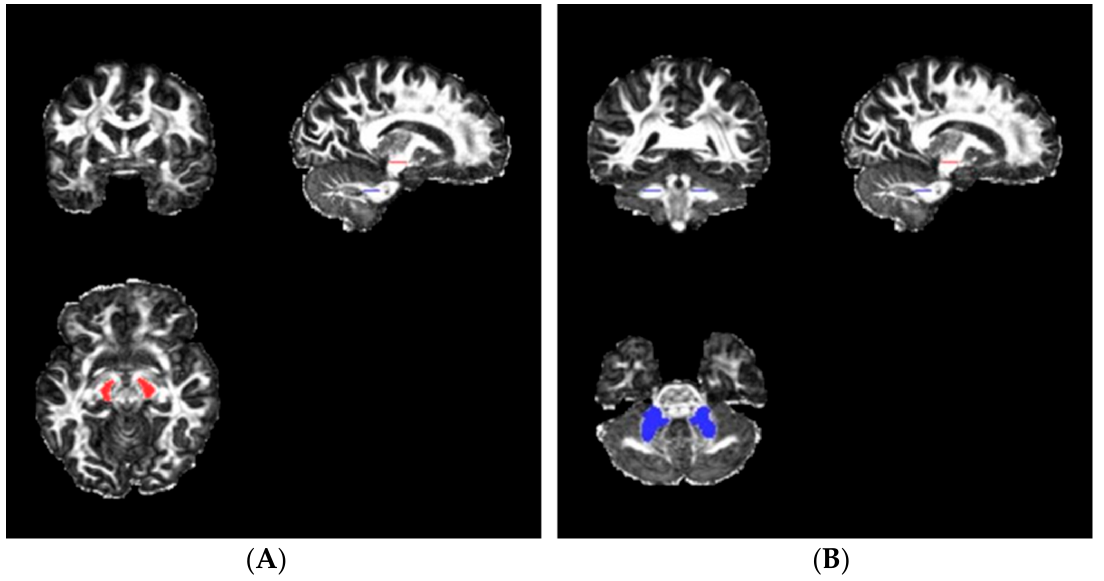
Figure 1. Region of interest definition. ( A ) Cerebral peduncle ROI. ( B ) Middle cerebellar peduncle ROI. Average FA and ADC values were calculated for CP-ROIs and MCP-ROIs. A